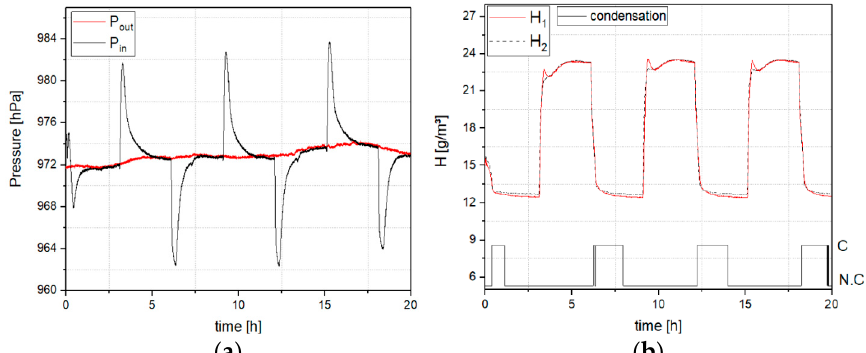
Figure 7. Pressure, absolute humidity and condensation measurements for the sealed battery system (without a PCE) during normal operation: ( a ) Pressure in the housing (P out : external pressure the sys- tem, P In : internal pressure the system) ( b ) Calculated absolute humidity of the air and condensation inside the housing (H 1 absolute humidity on the cold plate at input in the housing, H 2 : absolute hu- midity on the inner wall in the housing, black line: the detection of the condensation by the dew sensor, C: condensation detected, N.C: no condensation detected).